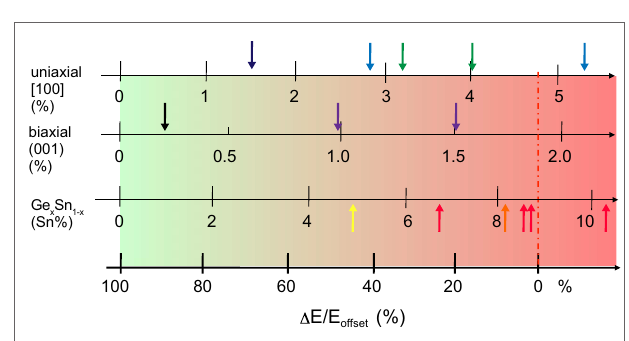
FiGURe 2 | Relative offset of the Γ - and L-conduction band minima realized in Ge either by uniaxial tensile strain along [100] direction [dark blue: (Capellini et al., 2013), light blue: (Nam et al., 2013; Sukhdeo et al., 2014), olive: (Süess et al., 2013; Geiger et al., 2014c)], biaxial tensile strain on (001) oriented substrate [black: (Liu et al., 2010); violet: (Ghrib et al., 2013, 2015)] or by alloying with Sn [yellow: (Chen et al., 2013a); orange (Gupta et al., 2013b); red: (wirths et al., 2015)] . The shown offset versus Sn concentration relates to the unstrained case. About 100% (0%) offset refers to 140 meV (vanishing energy offset). Hence, the dash-dotted line marks the transition from an indirect to a direct band gap semiconductor.